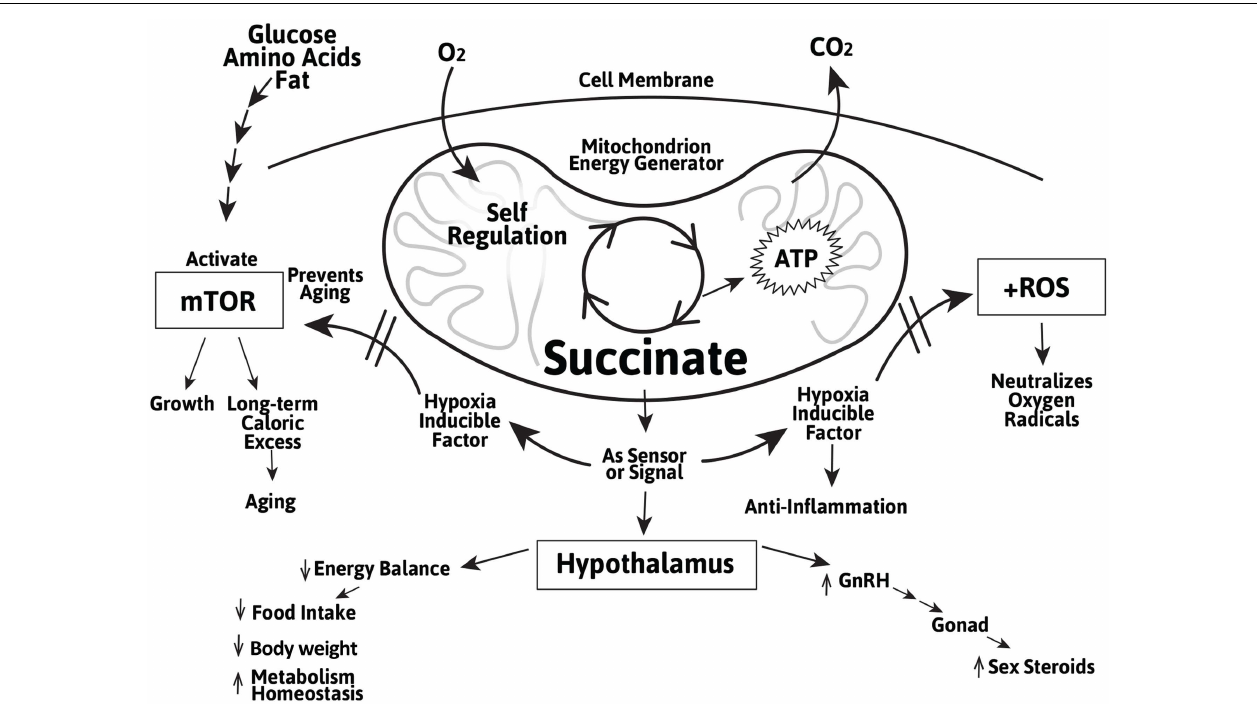
FIGURE 1 | Schematic representation of the role of the Krebs cycle intermediate succinate as a Krebs cycle intermediate in the mitochondrion and as an extra-mitochondrial sensor/signal in the regulation of cellular growth and aging mediated by mTOR and